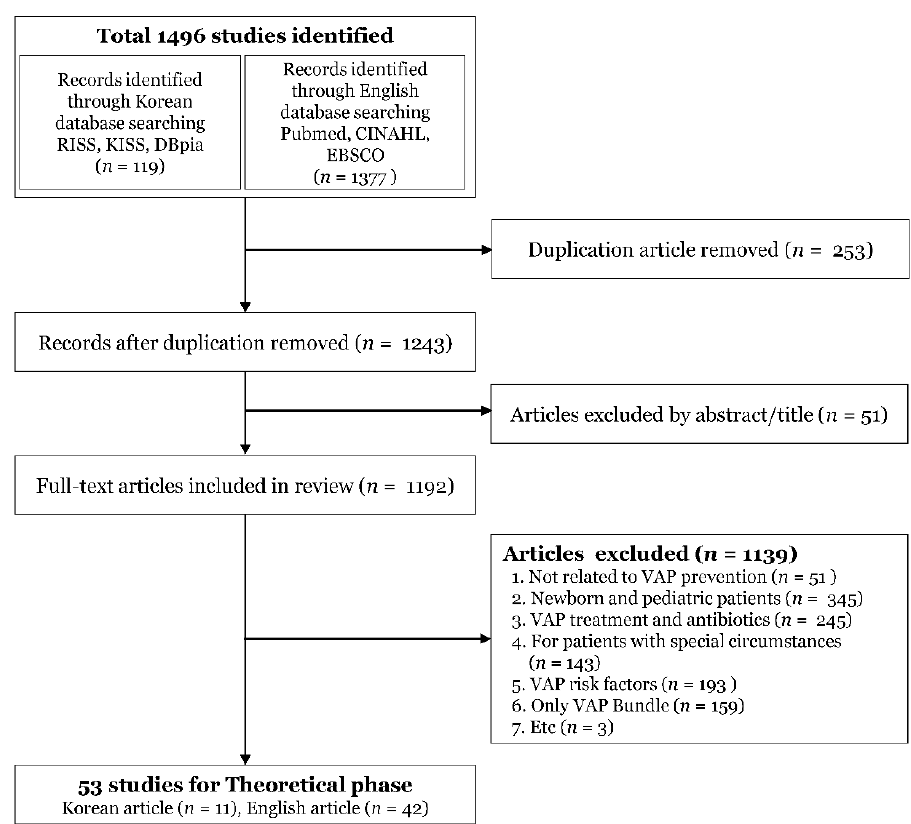
Figure 2. Literature search flow chart.